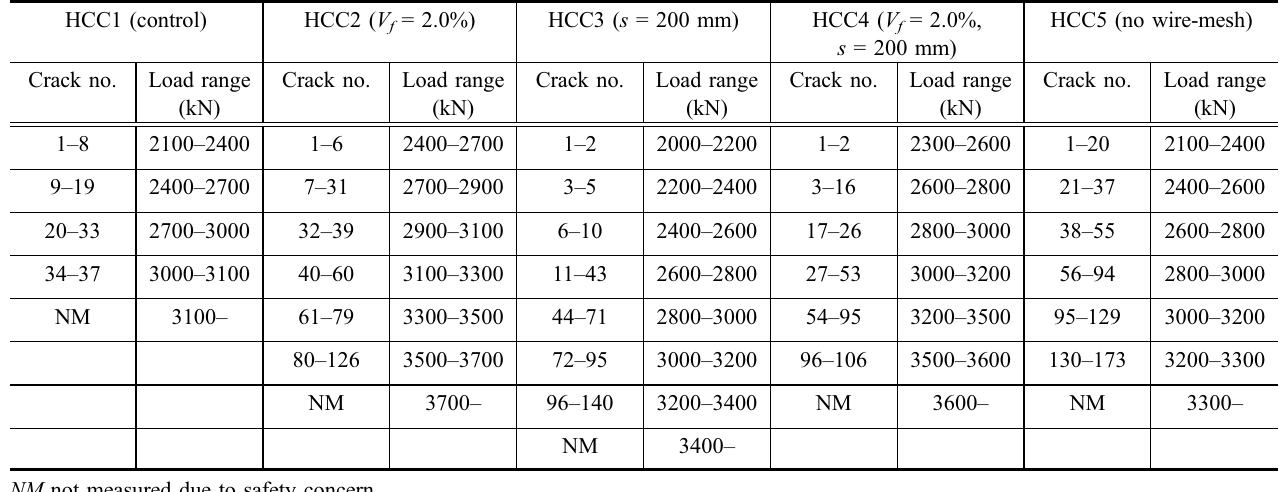
NM not measured due to safety